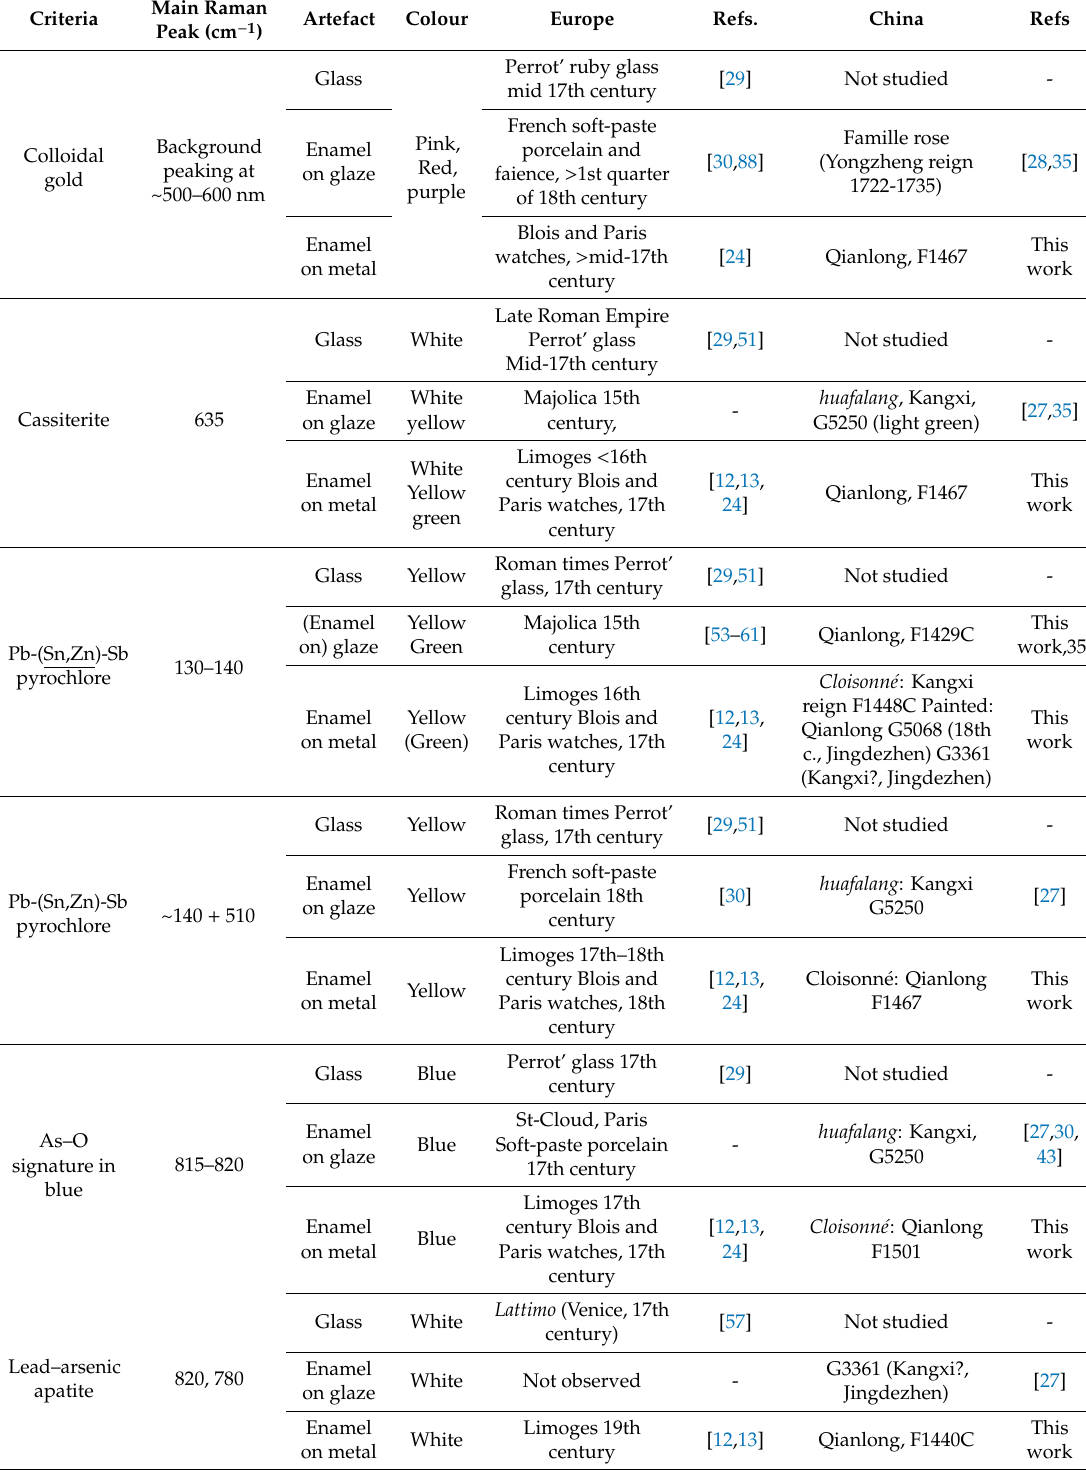
Table 7. Comparison between European and Chinese enamelling technologies, as evidenced from Raman studies (sh: